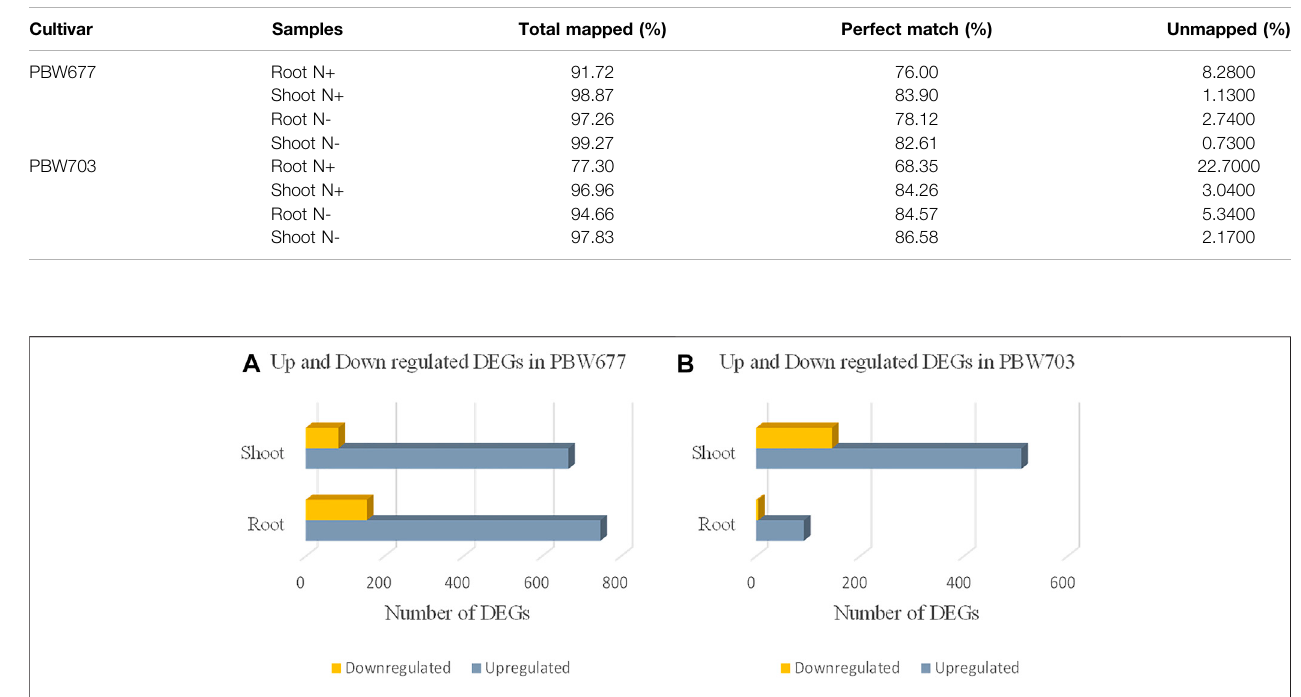
FIGURE 2 | Numbers of up and downregulated DEGs (differentially expressed genes) expressed in root and shoot tissues of (A) PBW677 and (B) PBW703.